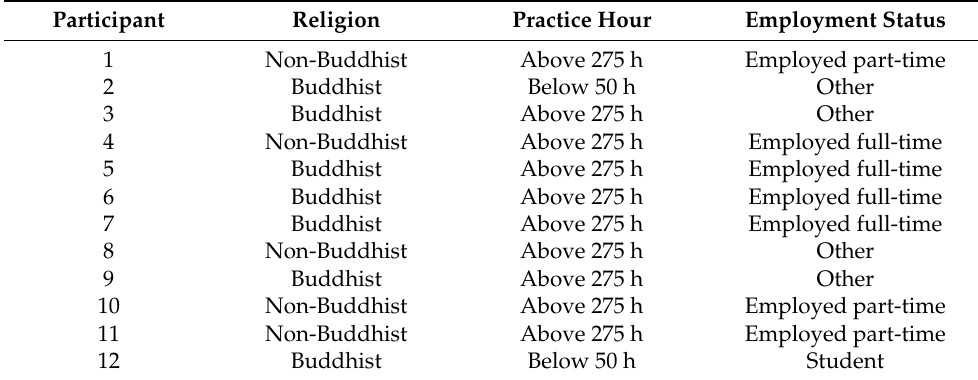
Table 2. Questionnaire participants’